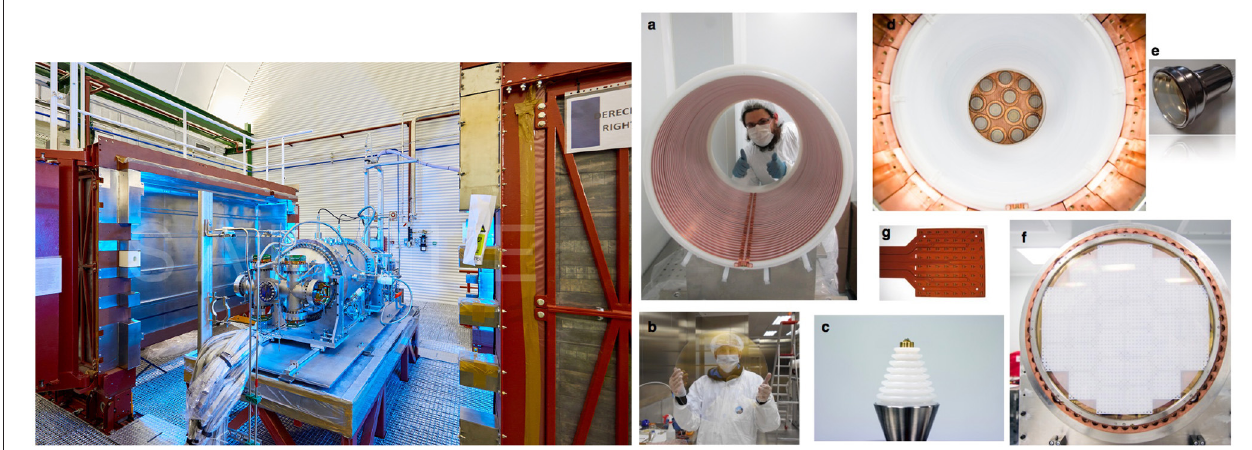
FIGURE 8 | Left: the NEXT-White detector at the LSC. Right: a selection of the main subsystems of NEXT-White: (a) the field cage; (b) the anode plate; (c) high voltage feedthrough; (d) energy plane; (e) PMTs used in the energy plane; (f) tracking plane; (g) kapton boards composing the tracking plane.